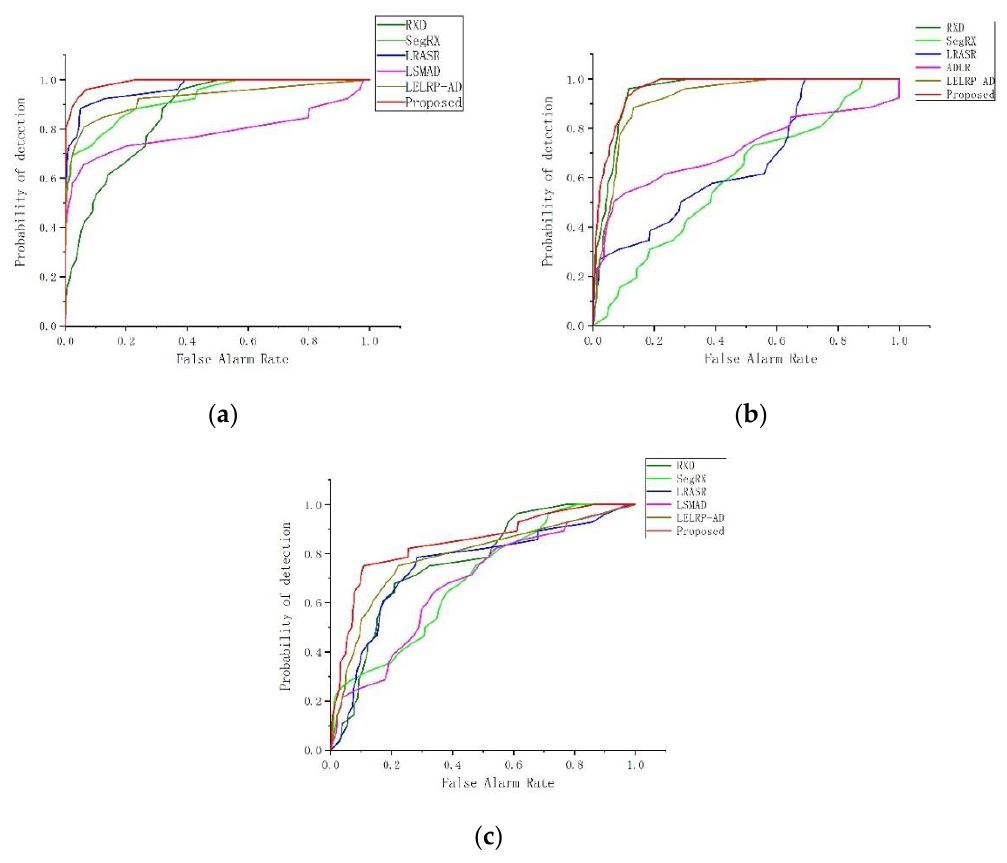
Figure 14. The target detection results of the different methods on the car data set . ( a ) RXD; ( b ) SegRX; ( c ) LRASR; ( d ) LSMAD; ( e ) LELRP-AD; and ( f ) EaSLRP.